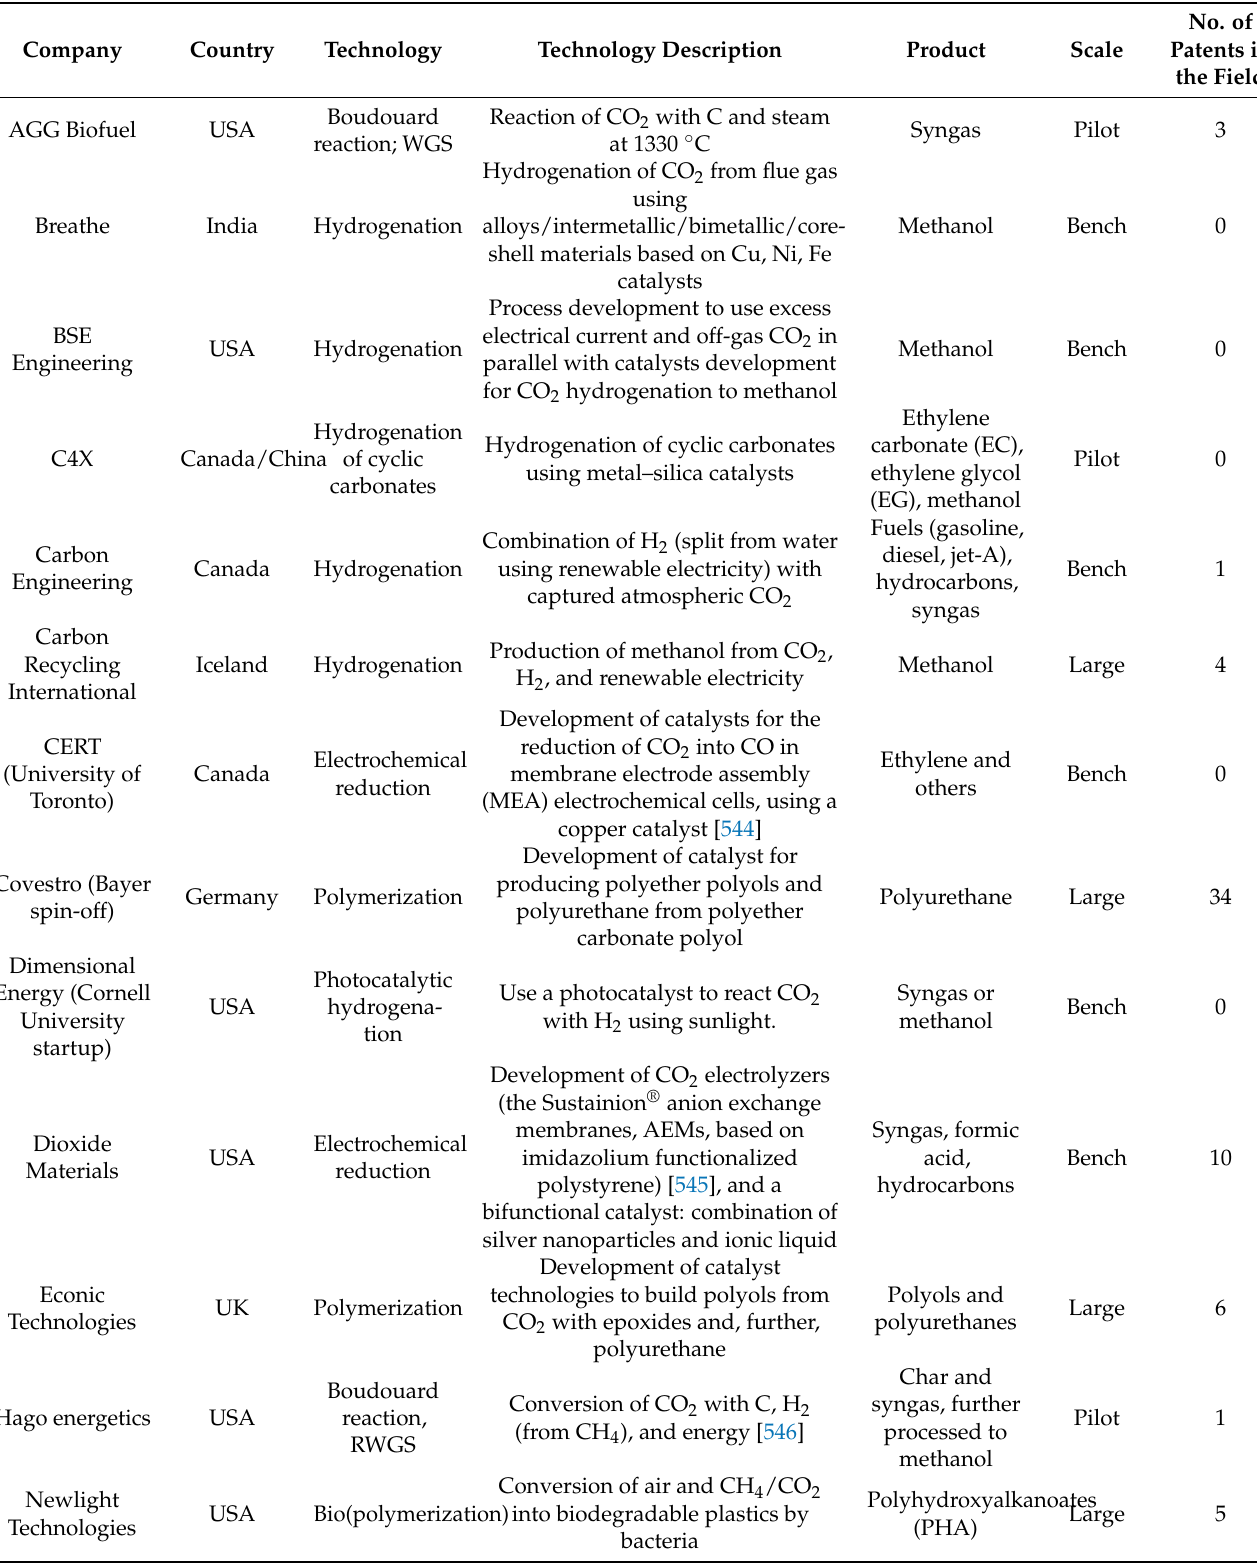
Table 27. Most active companies in the field of CO 2 utilization and respective